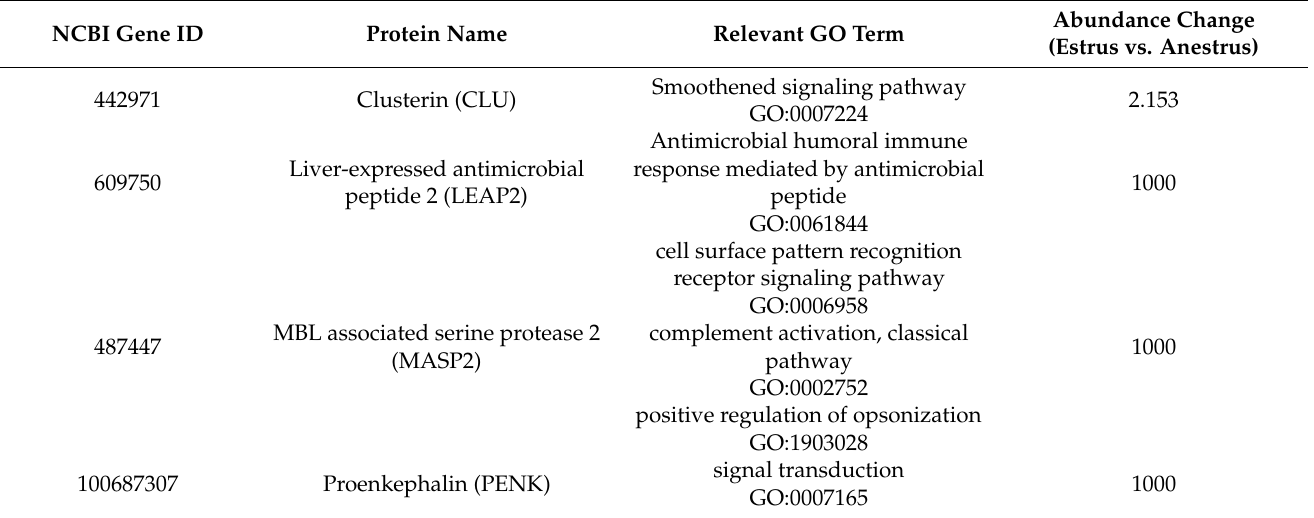
Table 4. List of proteins significantly altered in estrus vs. anestrus samples, which were identified as involved in signaling and as secreted/extracellular.